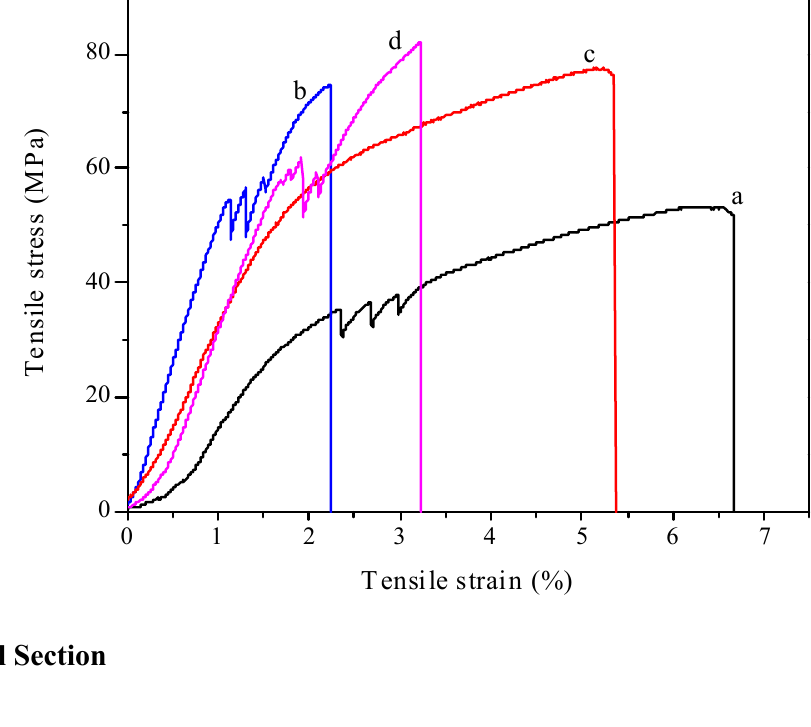
Figure 8. The tensile-strain curves of the films: ( a ) control sample; ( b ) cellulose film plasticized with sorbitol; ( c ) cellulose film plasticized with glycerol; ( d ) cellulose film plasticized with